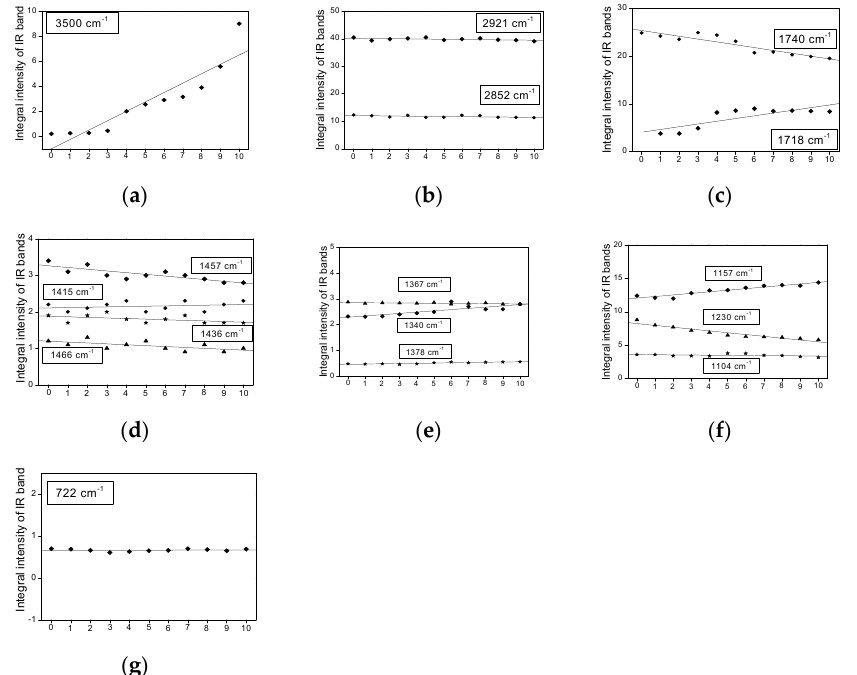
Figure 3. Heating-time dependence of the band intensity observed in the IR spectra of coconut oil at: ( a ) 3500, ( b ) 2921 and 2852, ( c ) 1740 and 1718, ( d ) 1466, 1457, 1436 and 1415, ( e ) 1378, 1367 and 1340, ( f ) 1230, 1157 and 1104, and ( g ) 722 cm − 1 .